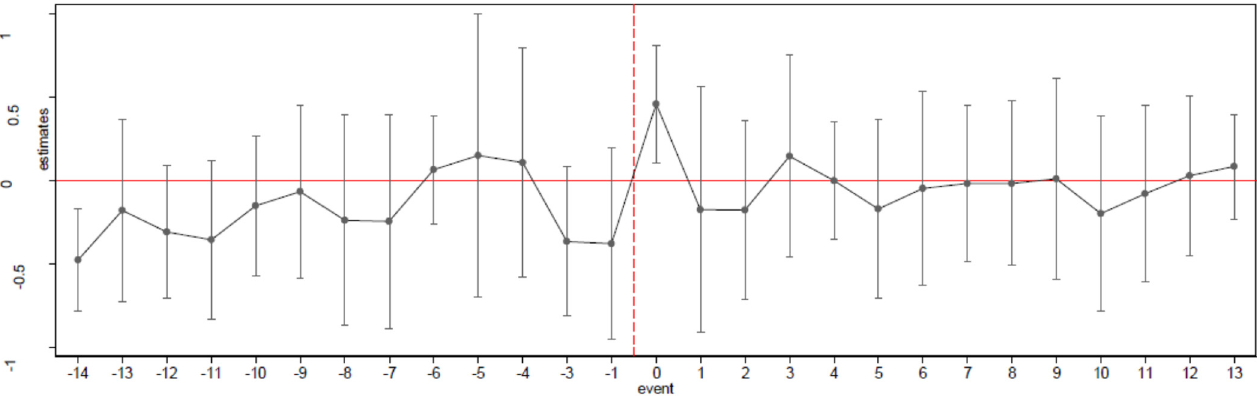
Figure 7. Parallel Trends Analysis—Event Studies on Loans Granted—Others Sector.